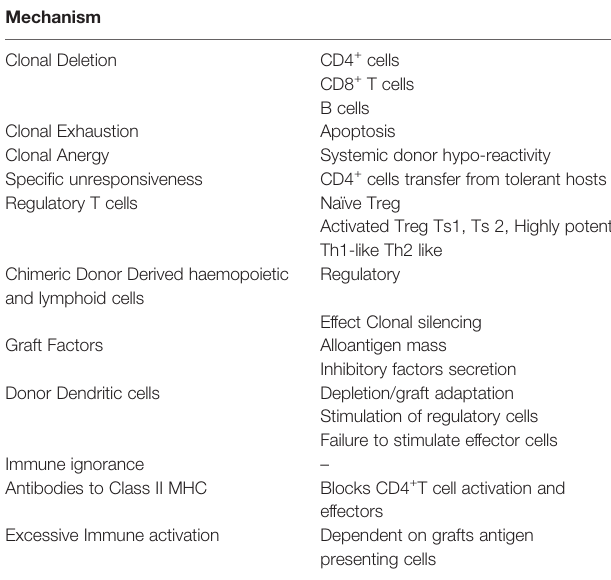
TABLE 1 | Immune Mechanisms described in Transplantation